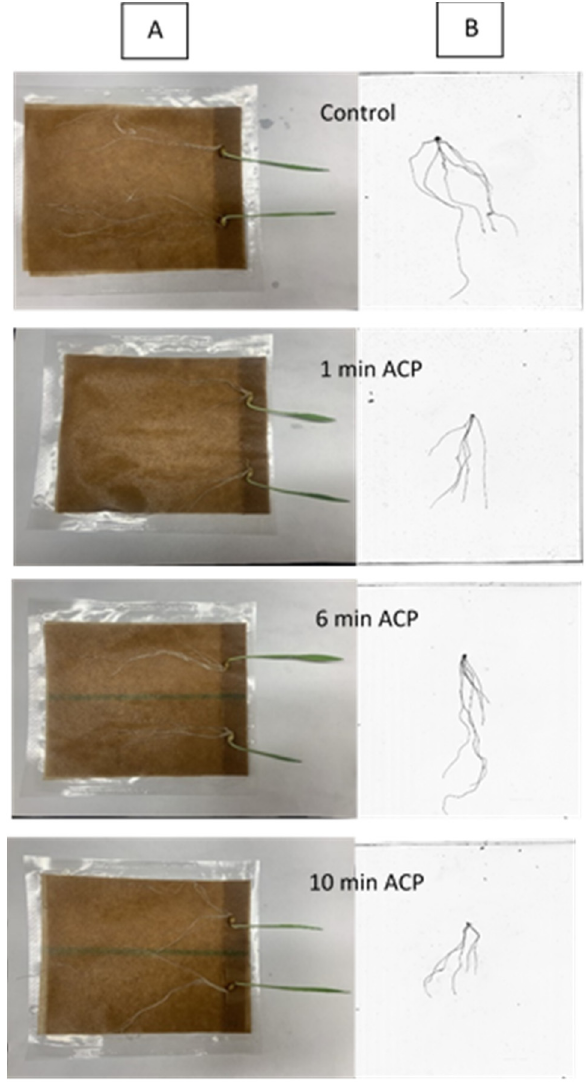
Figure 4. Effect of ACP treatment on seedling growth of barley after 7 days of germination. A: photo Figure 4. E ff ect of ACP treatment on seedling growth of barley after 7 days of germination. ( A ): photo images. B: scanned root images using WinRHIZO software. images. ( B ): scanned root images using WinRHIZO